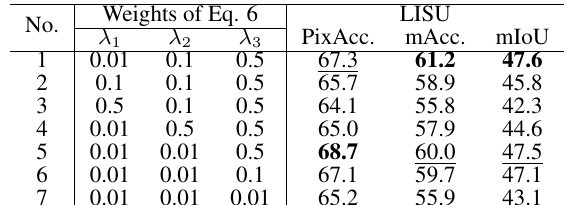
Table 6. Comparison of segmentation accuracy using DeepLab v3+ and its variants.